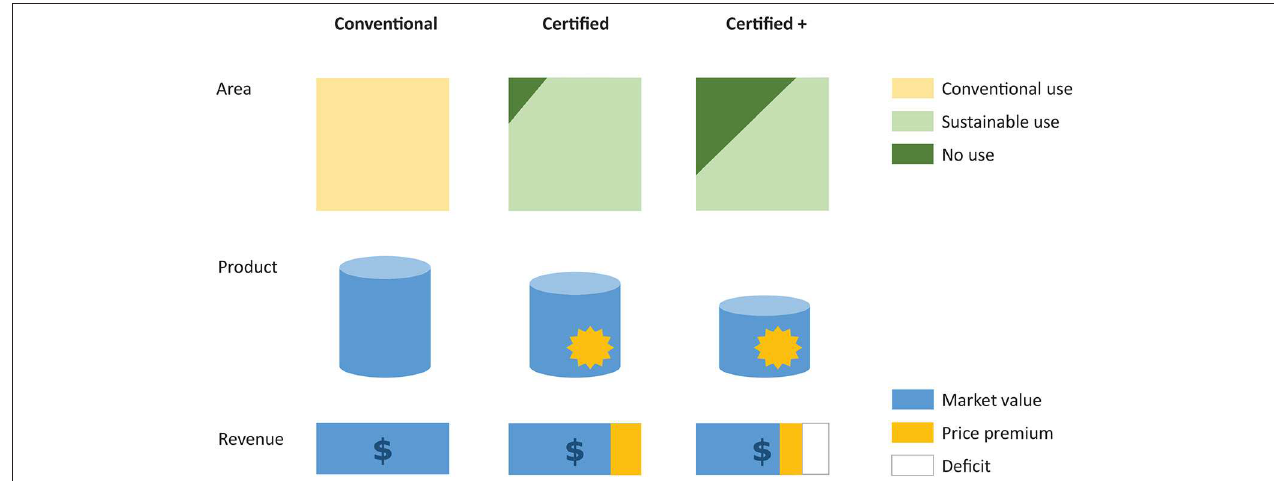
FIGURE 1 | Conceptual comparison between produced yields and income for the same area of forest under conventional and certified management. “Certified + ” stands for certification that includes protection of IFL.